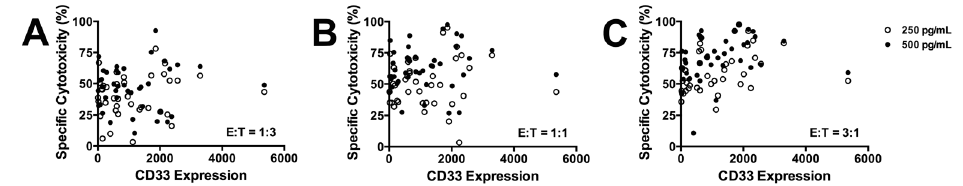
Fig 3. Relationship between CD33 expression and AMG 330-induced cytotoxicity. Relationship between CD33 expression on leukemic blasts (expressed as arbitrary fluorescence intensity) and drug- induced cytotoxicity with AMG 330 at 250 pg/mL (open symbol) and 500 pg/mL (closed symbol) in the presence of T-cells from a single healthy donor at an E:T cell ratio of (A) 1:3, (B) 1:1, and (C) 3:1, determined after 48 hours.